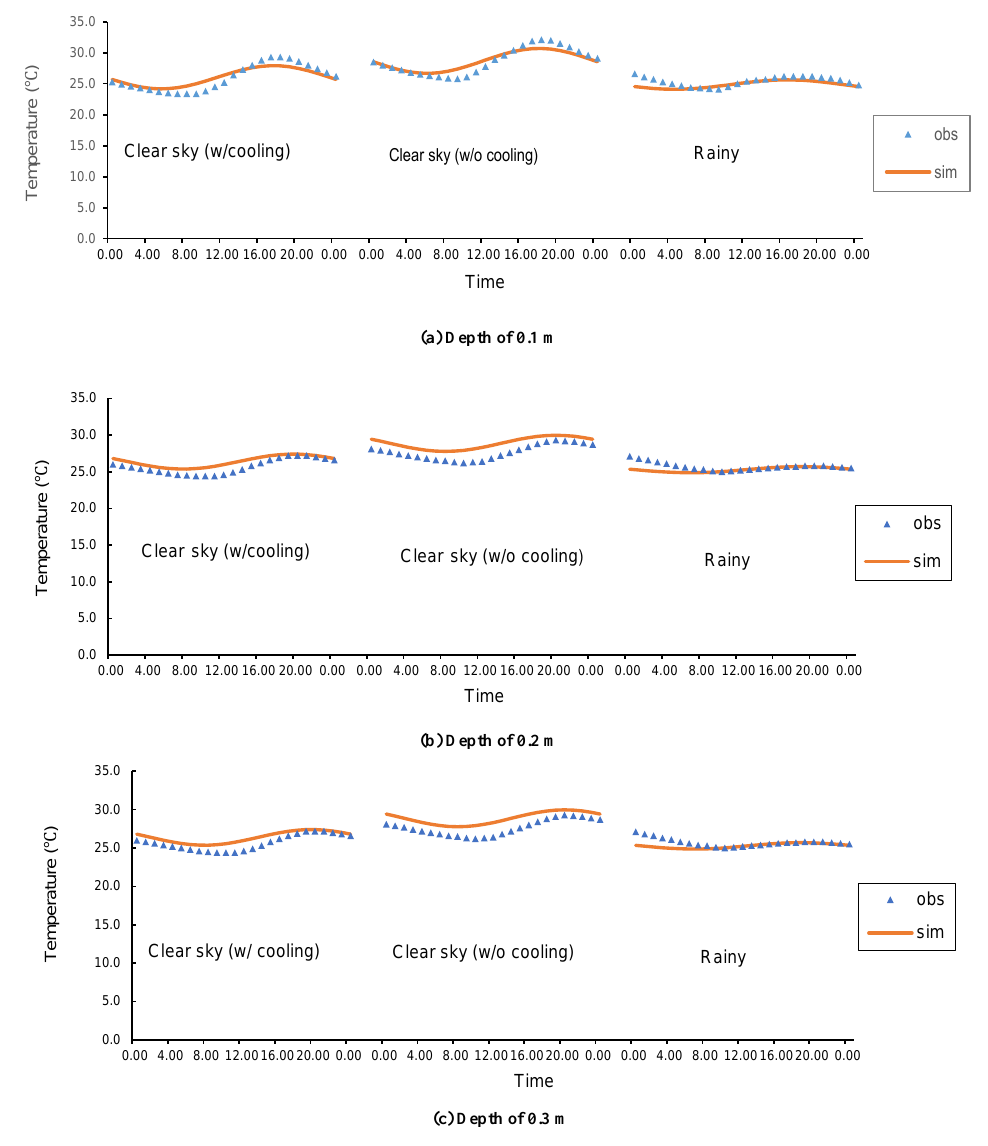
Figure 6. Simulation results for the cooling season soil temperatures at 0.1 m, 0.2 m, and 0.3 m soil depths under various aerial conditions: clear-sky or rainy day, with or without active cooling.